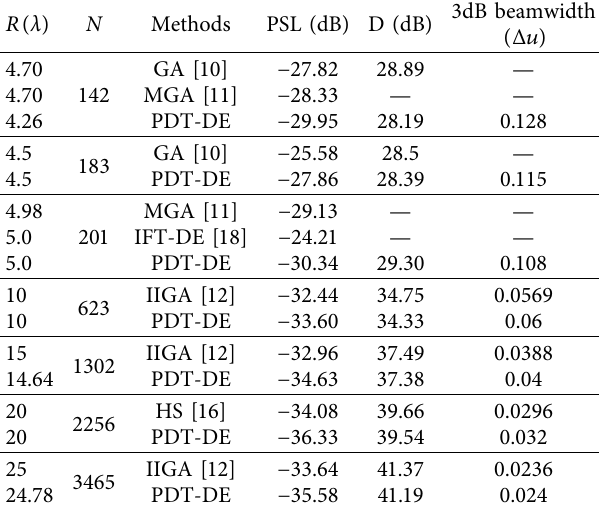
Table 3: Comparative results by using different